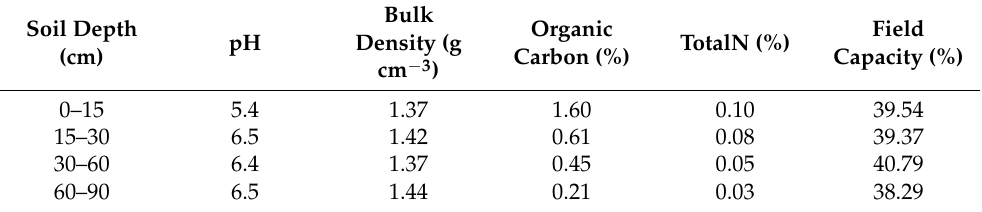
Table 3. Physicochemical properties of the initial experimental